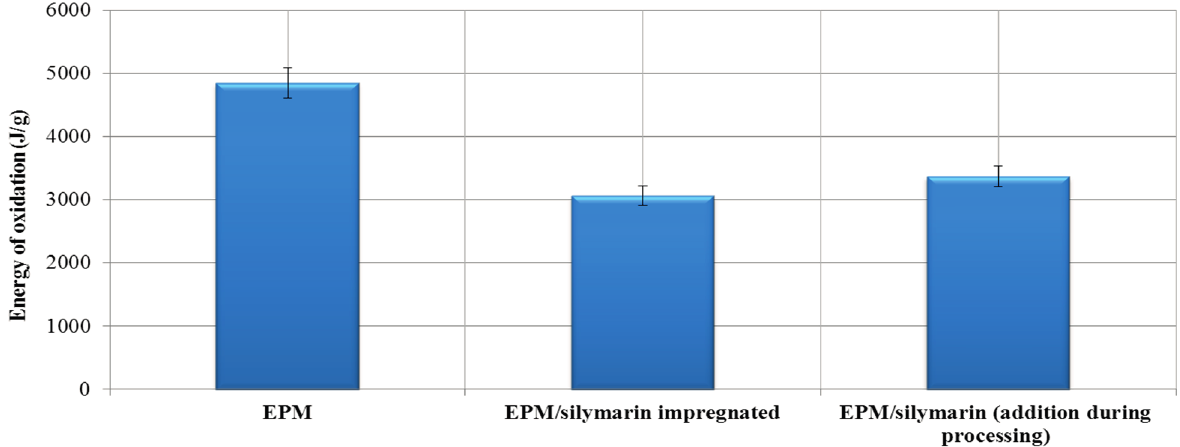
Figure 4. Oxygen induction time of EPM composite with silymarin.